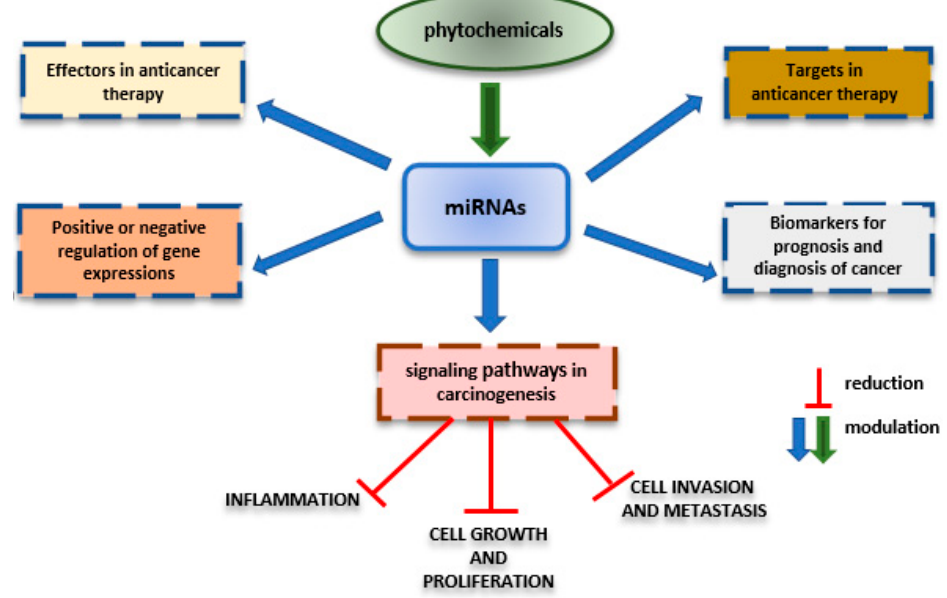
Figure 2. Phytochemicals and miRNAs involved in carcinogenesis process.